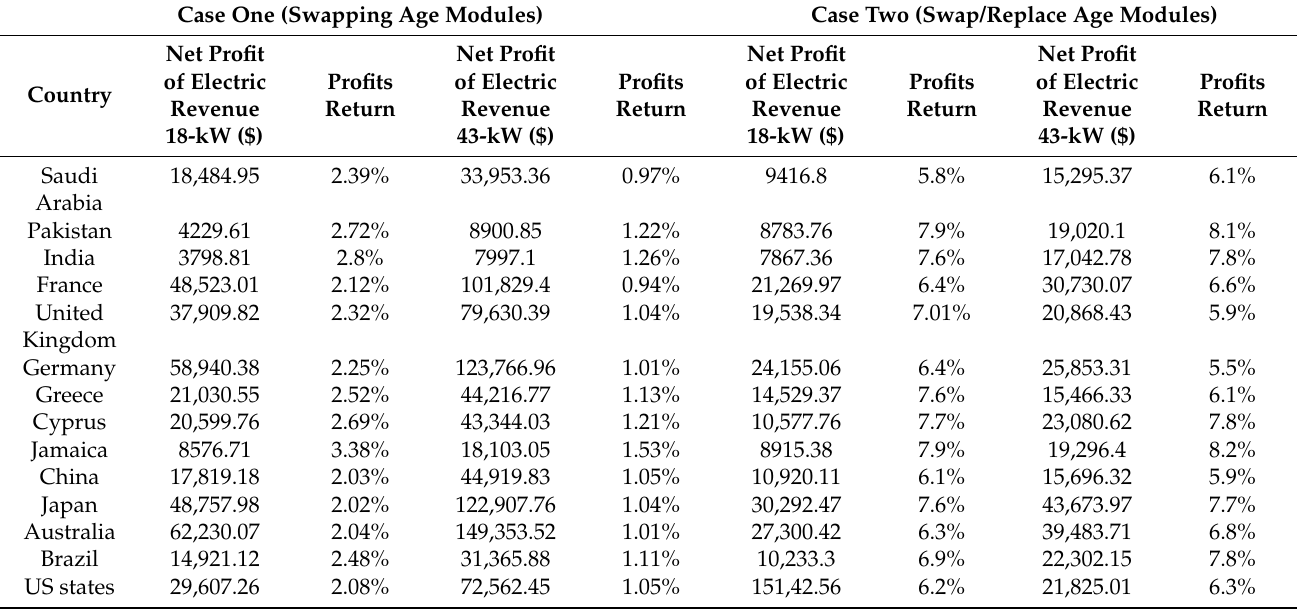
Table 14. Comparative analysis of electric revenue rate returns in 14 countries over a period of one decade. Case One (Swapping Age